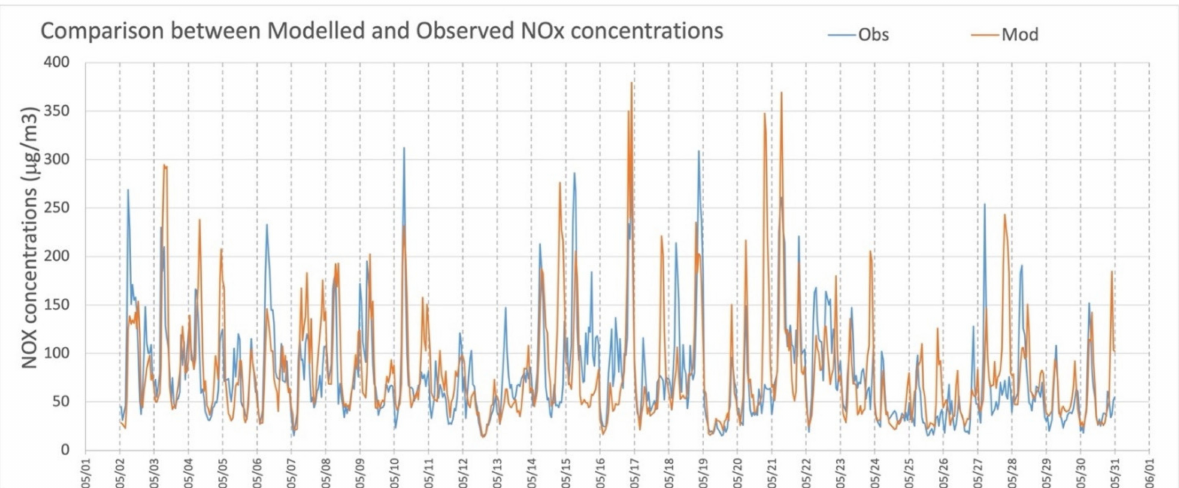
Figure 8. Hourly NOx concentration comparisons between observations (blue line) and simulations (orange